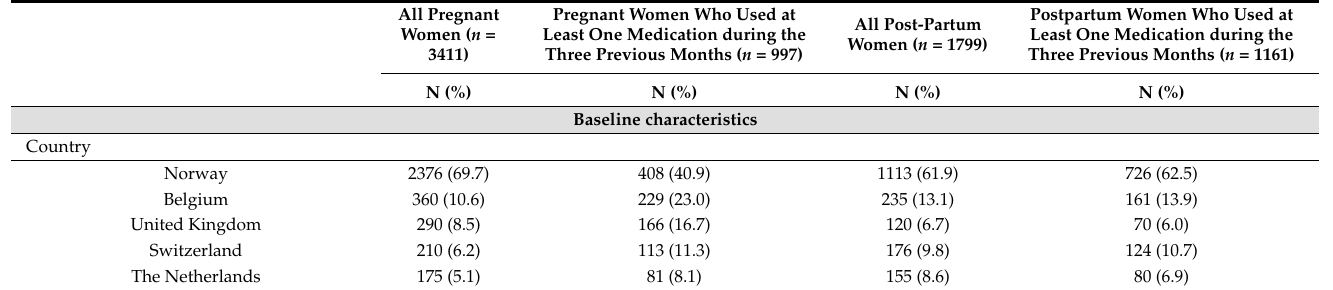
Table 1. Characteristics of the participants according to any medication use in the last three months ( n =